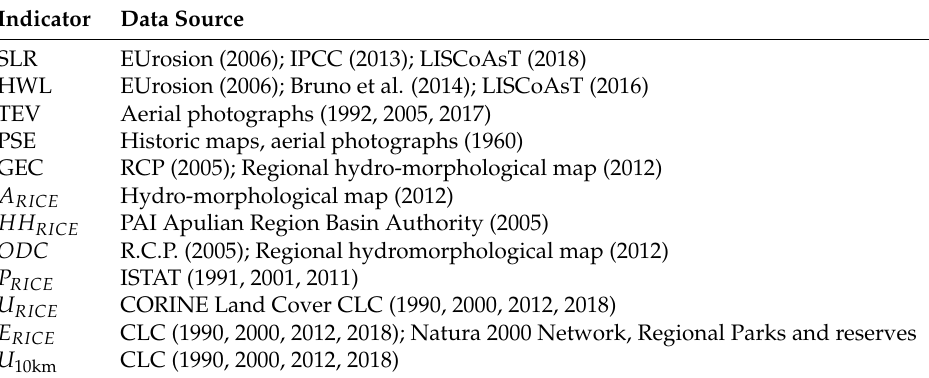
Table 5. Reference database of CVI and CEI